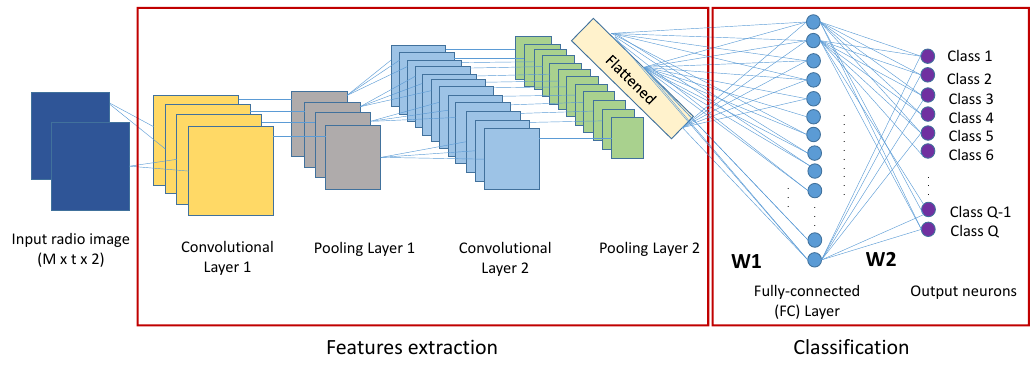
Figure 5. An example of a CNN architecture with two convolution layers and one fully-connected